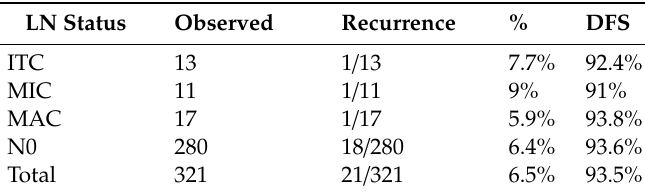
Table 1. Patients definitive lymph nodal